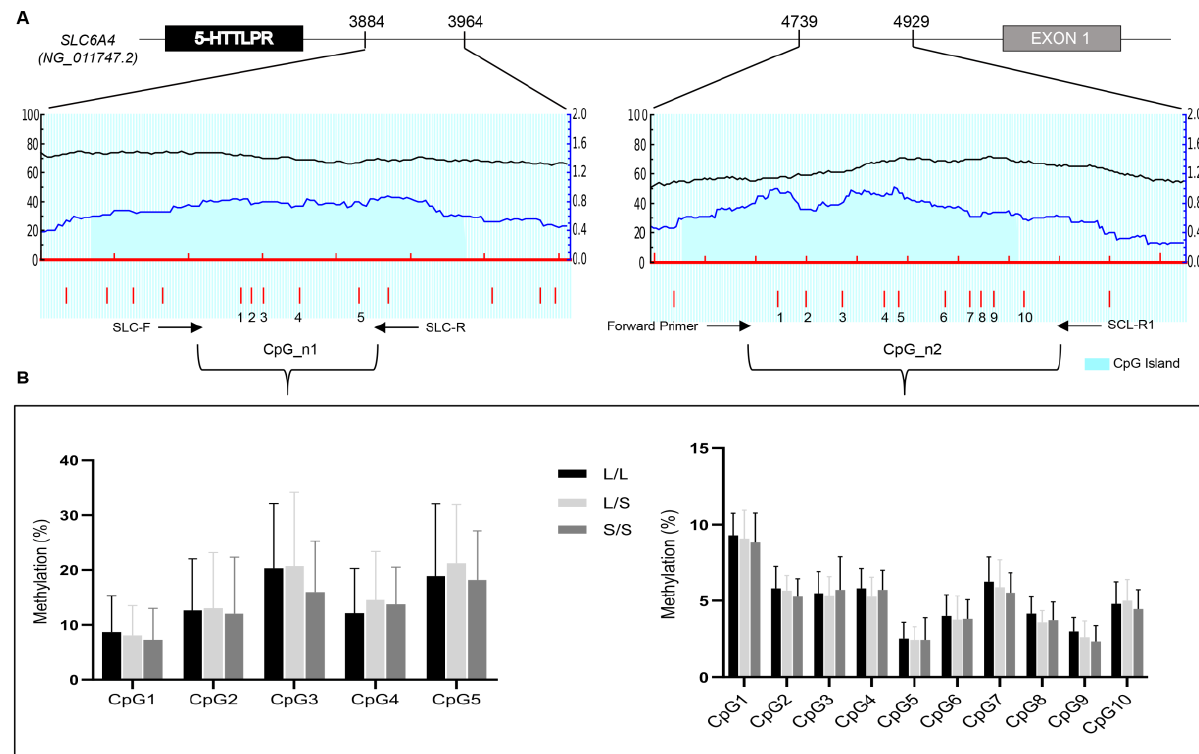
Figure 1. Methylation analysis of SLC6A4 . ( A ) Upper panel: schematic representation of SLC6A4 promoter region. Gray box as exon 1, black box as 5-HTTLPR polymorphism location, and intronic sequences as thick black line. Lower panel: CpG island (blue region) identified by MethPrimer program [33]. The first CpG island indicated as CpG_n1 is located at the end of the 5-HTTLPR polymorphism (accession number: NG_011747.2, position 3884–3964). The second CpG island indicated as CpG_n2 is the promoter region previously described [27] (accession number: NG_011747.2, position 4739–4929). Vertical red bars indicate relative positions of CpG sites that are numbered from 1 to 5 for CpG_n1 island and from 1 to 10 for CpG_n2 island. The PCR primers used in this study are indicated as arrows. ( B ) Histogram of the average methylation percentage in patients with stroke carrying the LL (Long Long), LS (Long Short), and SS (Short Short) alleles for each CpG island.